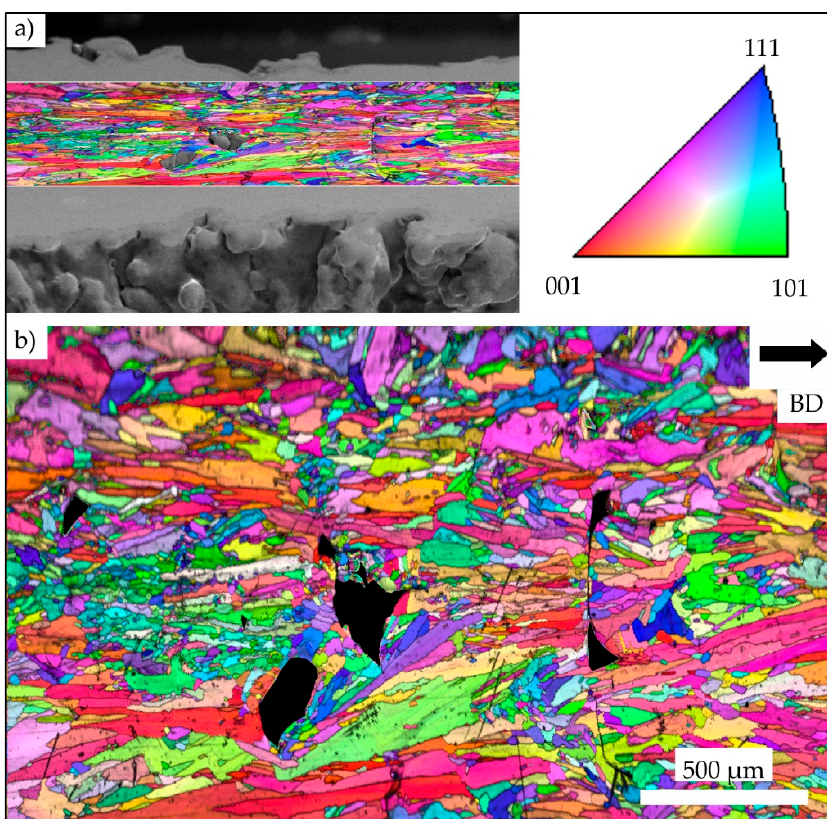
Figure 4. Inverse pole figure (IPF) map of a strut with 3 mm diameter highlighting a plane parallel to the build direction (BD) with grain orientations plotted for the BD. ( a ) Mapped area with reference to the overall strut dimensions; ( b ) probed volume depicted in normal view for further analysis. All defects already seen in ( a ) are colored black in ( b ). Color coding is according to the standard triangle shown in the upper right.